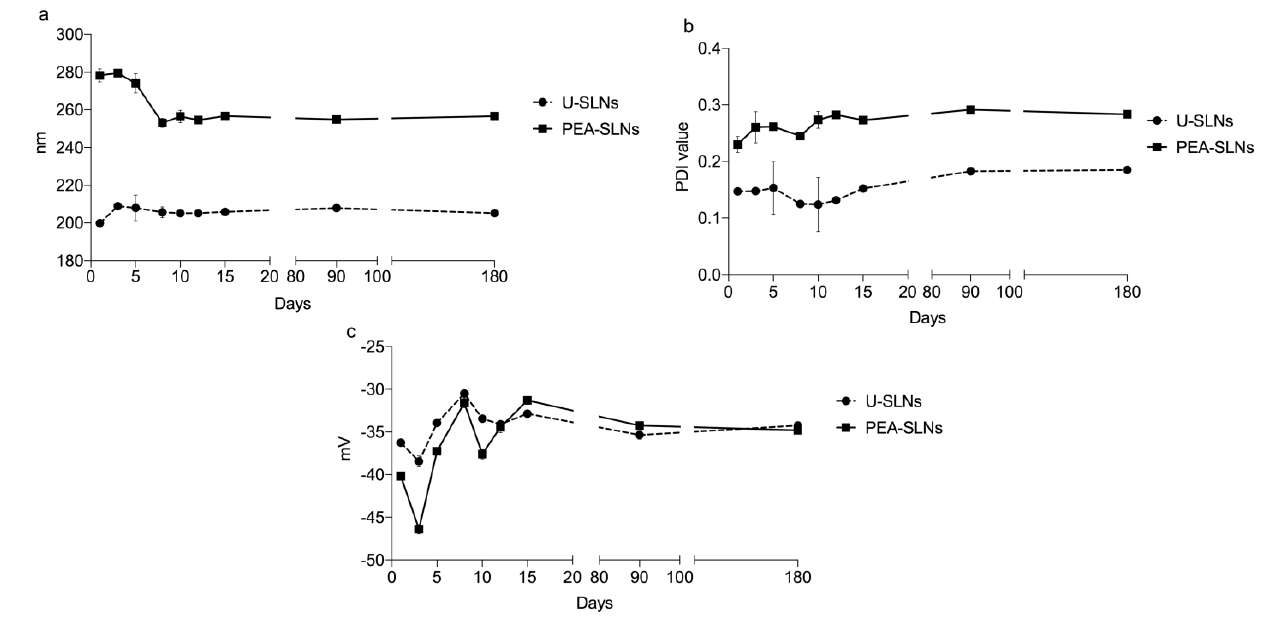
Figure 1. Physical stability of U-SLNs and PEA-SLNs determined by monitoring size ( a ), PDI ( b ), and Z-potential ( c ) values over time.